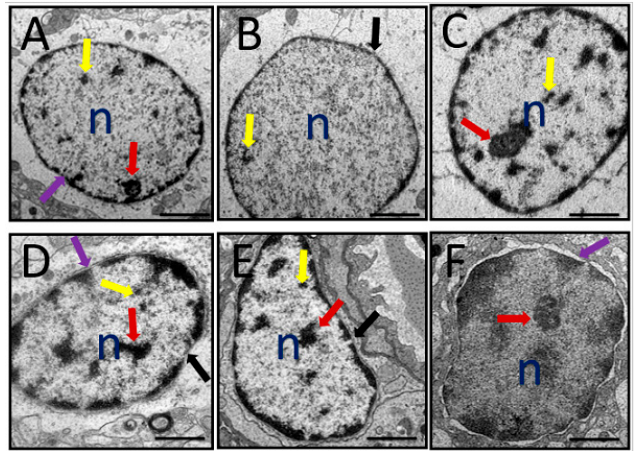
Figure 7. A representative TEM micrograph depicting rat’s prefrontal cortex with identified nucleus abnormalities after administration of D-gal and AlCl 3 and those co-administered with donepezil and